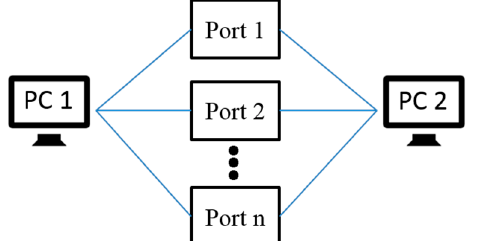
Figure 4. The diagram of the vertical scanning schematic.